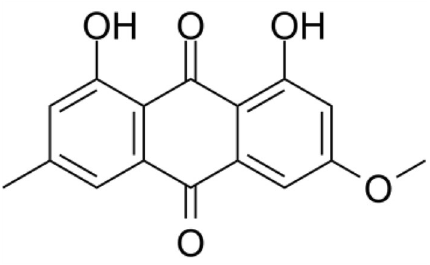
Figure 1. Structure of parietin